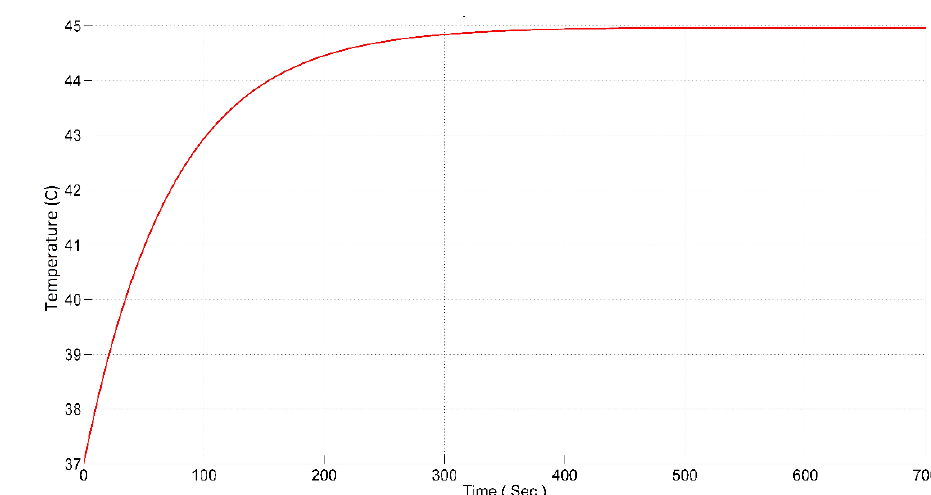
Figure 11. Simulink model of the plant with SMC controller.